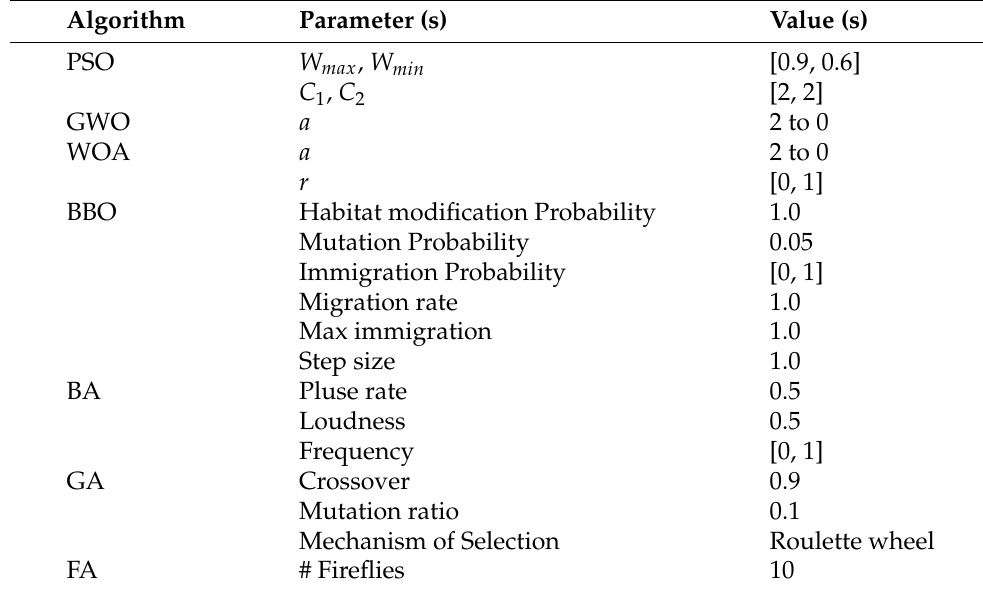
Table 4. Configuration parameters of the compared